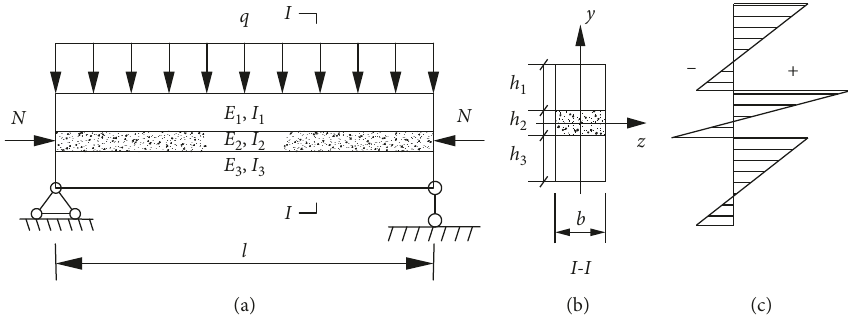
Figure 1: Mechanical model of the composite rock beam: (a) beam plane; (b) beam section; (c) stress distribution.